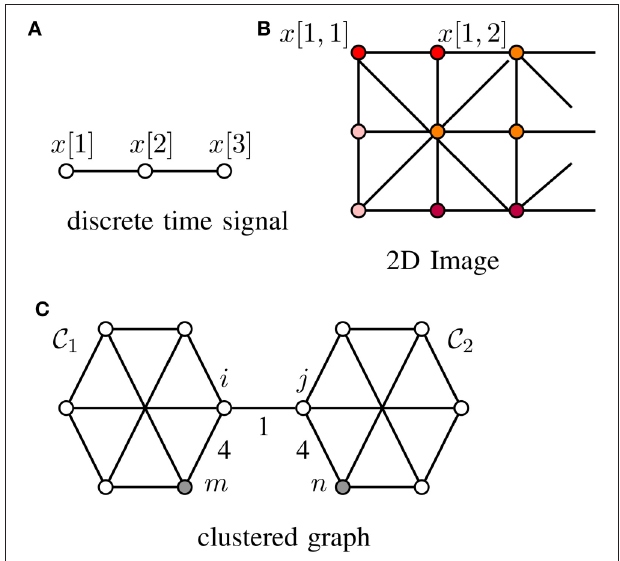
FIGURE 1 | Graph signals defined over (A) a chain graph (representing, e.g., discrete time signals), (B) grid graph (representing, e.g., 2D-images) and (C) a general graph (representing, e.g., social network data), whose edges { i , j }∈ E are captioned by edge weights W i , j .